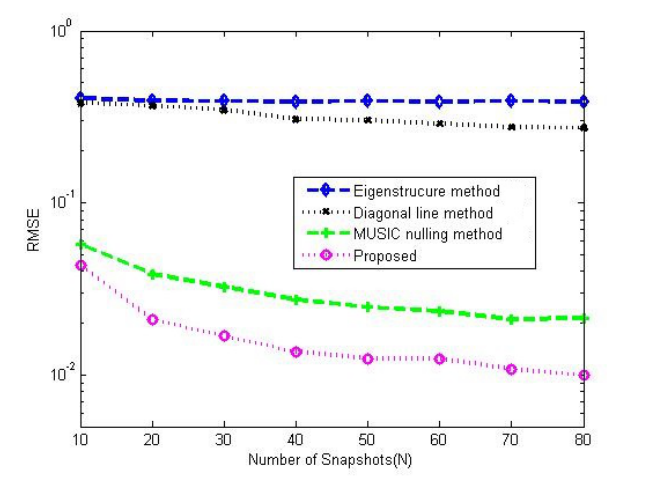
Figure 9. RMSE performance comparison among the corresponding gain-phase estimation methods versus number of array element in the case of random gain-phase errors, CSR = 30 dB, SNR = 20 dB, K 0 = 20, T = 80, N = 40.